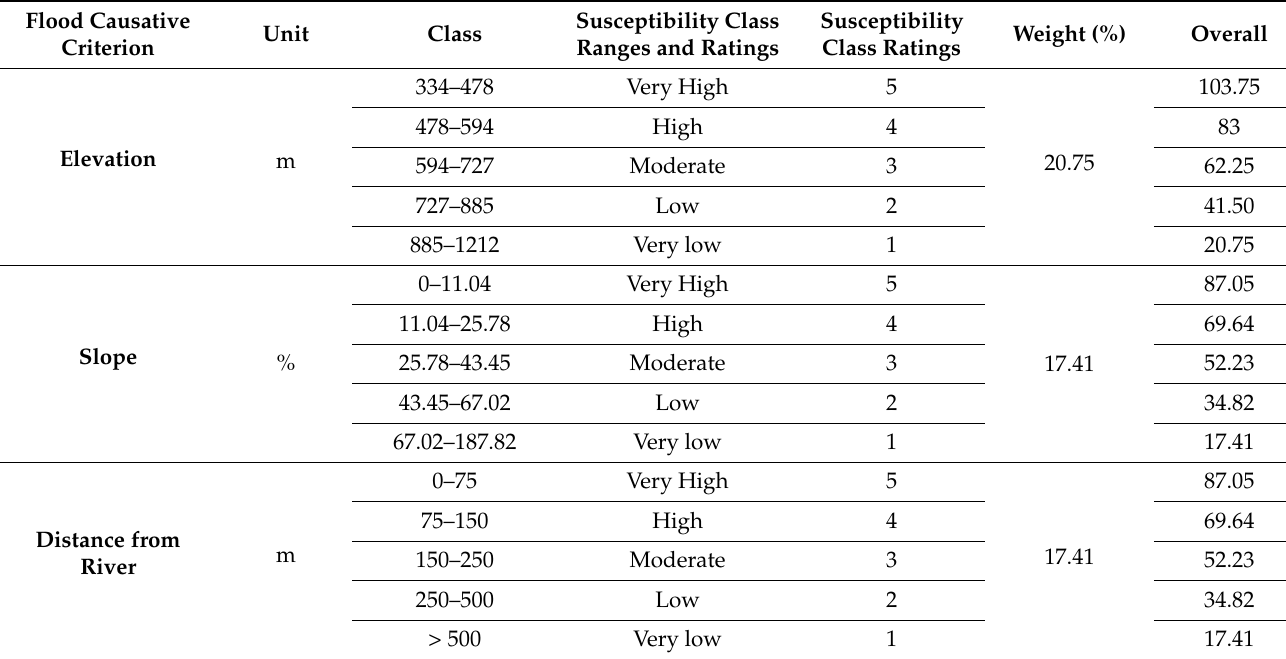
Table 3. Sub criteria of each parameter and their